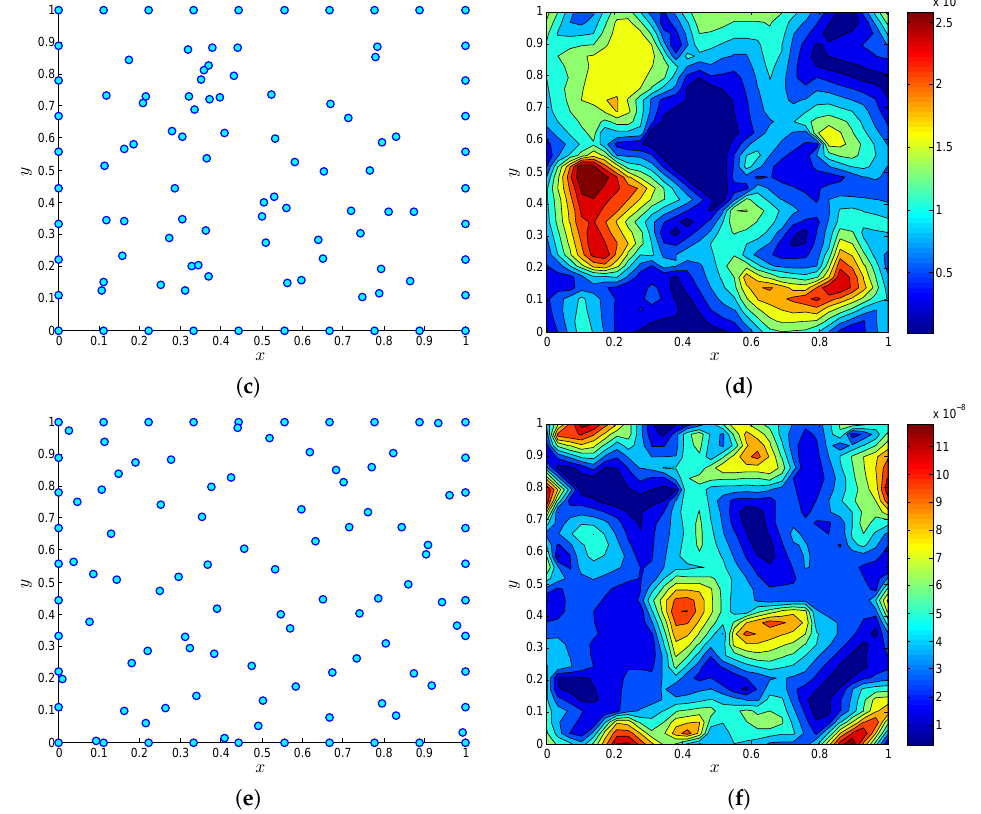
Figure 3. L ∞ error norm with different non-uniform nodes for Problem 2. ( a ) Chebyshev nodes N = 100; ( b ) L ∞ error norm using Chebyshev nodes; ( c ) random nodes N = 100; ( d ) L ∞ error norm using random nodes; ( e ) Halton nodes N = 107; ( f ) L ∞ error norm using Halton nodes.